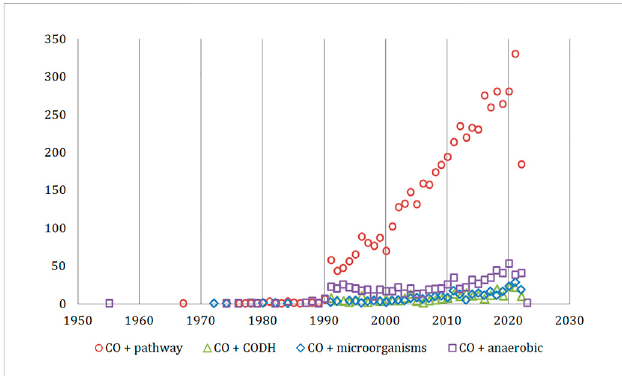
FIGURE 2 The timeline of research areas for “ carbon monoxide ” articles relevant to the scope of this review (Web of Science Core